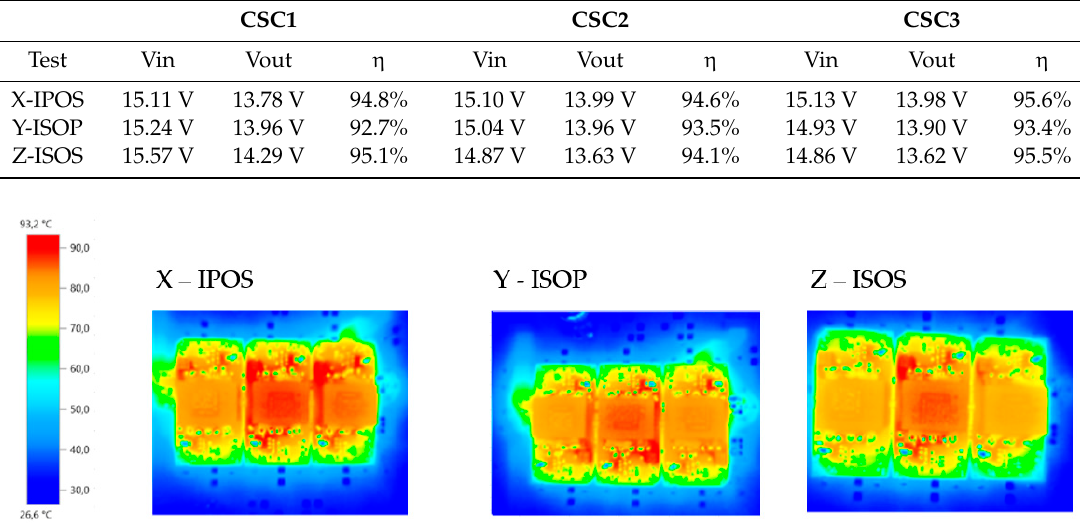
Figure 16. Thermal images of various PCA configurations with the same CAA arrangement.